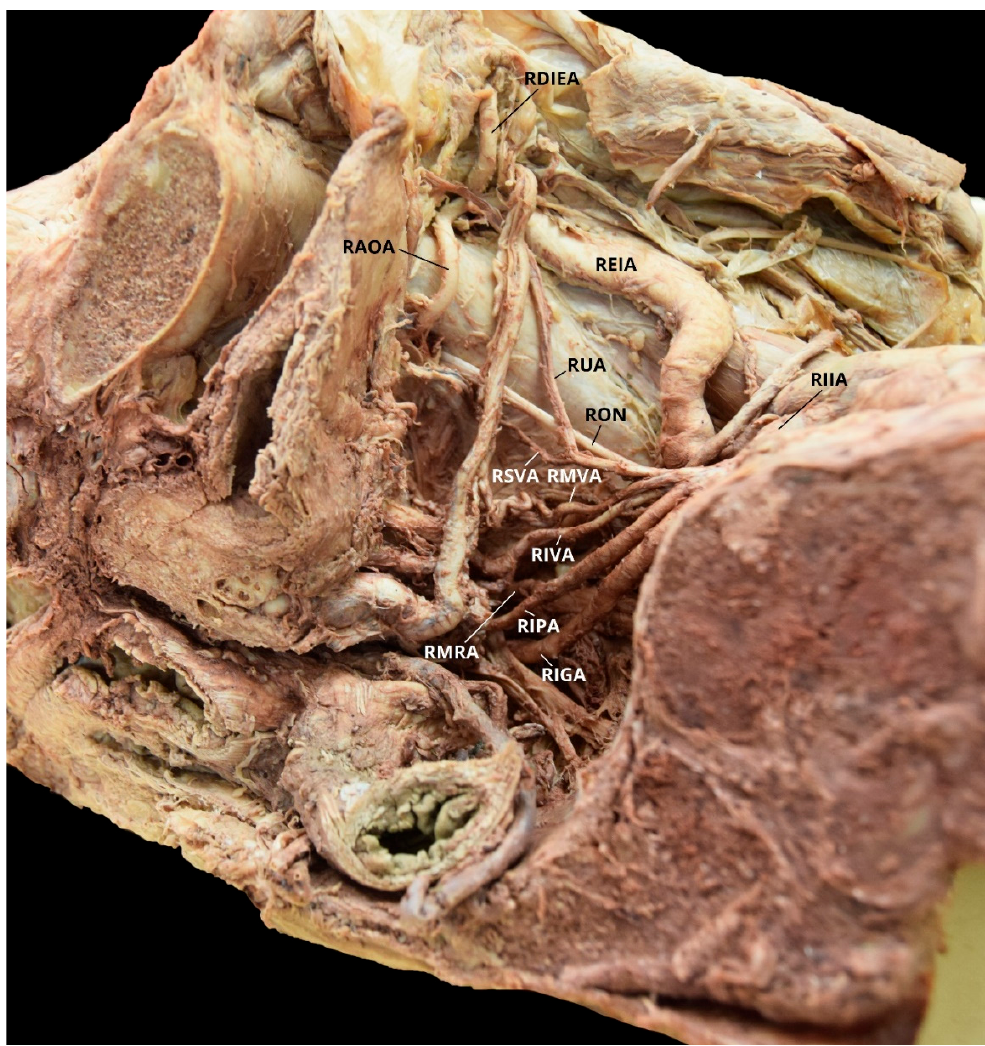
Figure 12. Facilitated display highlighting the right internal iliac artery branches with the right aberrant obturator artery for Case 7. RAOA = Right Aberrant Obturator Artery; RDIEA = Right Deep Inferior Epigastric Artery; REIA = Right External Iliac Artery; RIGA = Right Inferior Gluteal Artery; RIIA = Right Internal Iliac Artery; RIPA = Right Internal Pudendal Artery; RIVA = Right Inferior Vesical Artery; RMRA = Right Middle Rectal Artery; RMVA = Right Middle Vesical Artery; RON = Right Obturator Nerve; RSVA = Right Superior Vesical Artery; RUA = Right Umbilical Artery. The Right Iliolumbar Artery (RILA), Right Inferior Lateral Sacral Artery (RILSA), Right Superior Gluteal Artery (RSGA), and the Right Superior Lateral Sacral Artery (RSLSA) are not pictured.